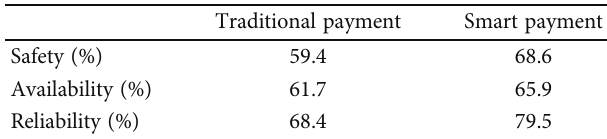
Table 1: Comparison of the advantages of smart payment and traditional